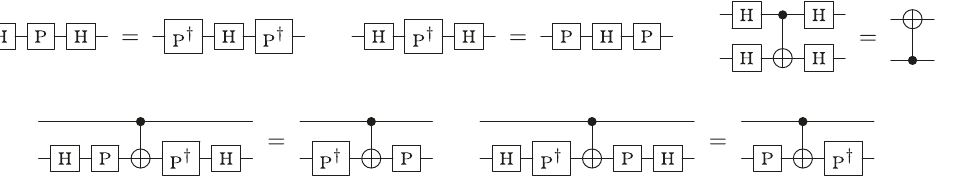
Fig. 4 Hadamard gate reductions. The two rules illustrated on the bottom can be applied even if the middle CNOT gate is replaced by a circuit with any number of CNOT gates, provided they all share the target of the original CNOT